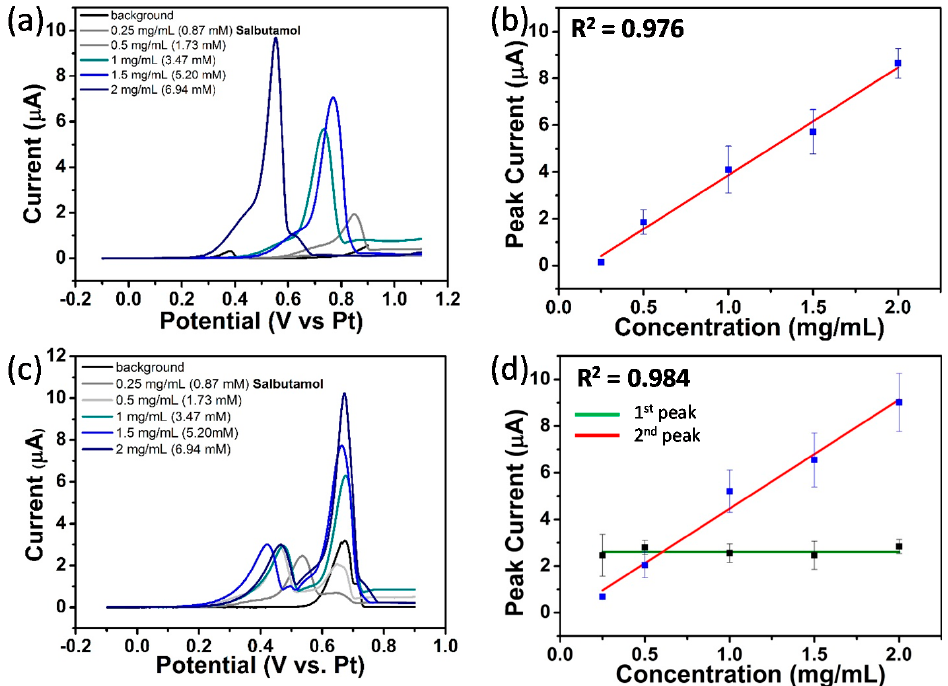
Figure 11. ( a ) LSVs at bare gold microdisc array electrodes at 10 mV s − 1 in background solution (pH 4) and in Ventolin TM solutions (pH 4) containing 0.25, 0.5, 1, 1.5 and 2 mg/mL salbutamol (as sulphate) in 0.0154 M NaCl and 0.05 mM H 2 SO 4 ; ( b ) plot of peak current vs. salbutamol concentration at bare gold electrodes; ( c , d ) are the equivalent of ( a , b ) at NPG electrodes.